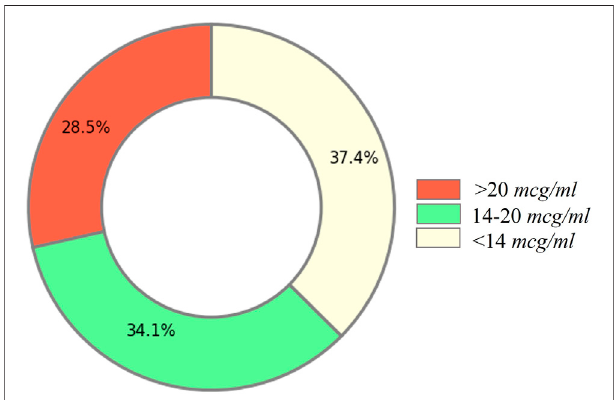
FIGURE 3 | Distribution of the vancomycin trough